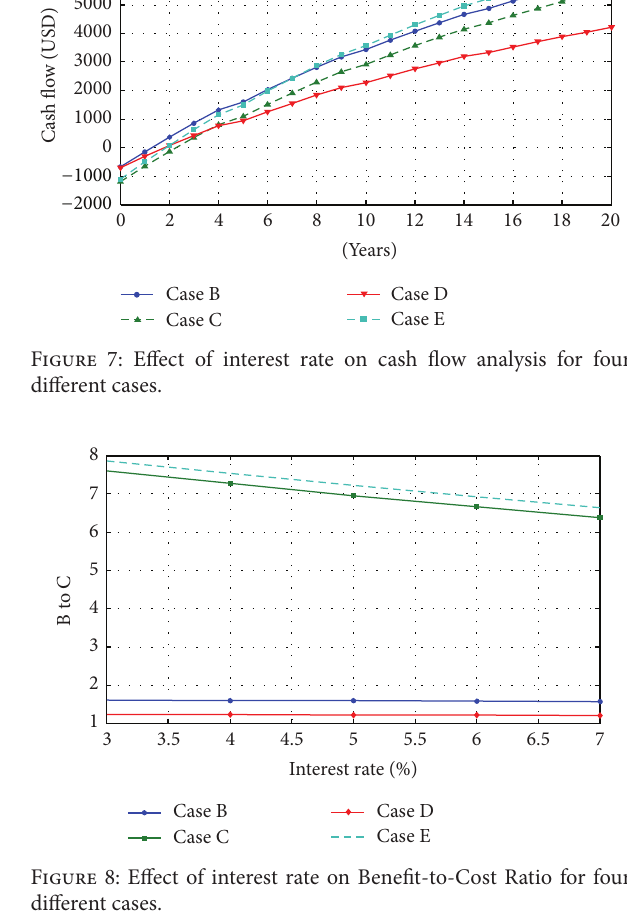
ing rickshaw puller, structure of rickshaw, PV module, and = 0.3 . Table 5 gives total resistive other components) and 𝐶 rr forces and the required power 𝑃 𝑟